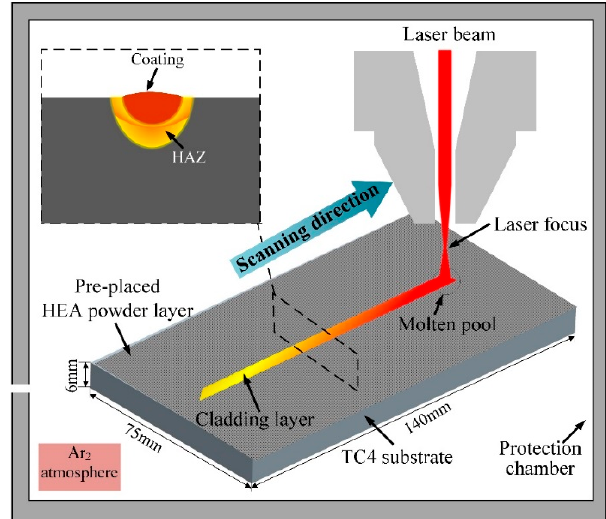
Figure 2. Schematic diagram of the experimental setup for the process.